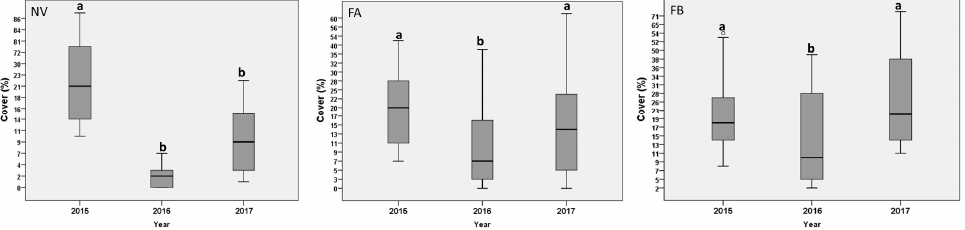
Figure 1. Percentage total cover of each species for the different locations (NV, FA, and FB) before (2015) and after (2016 and 2017) harvesting. Values followed by the same letter do not differ significantly according to Newman-Keuls test ( p < 0.05).